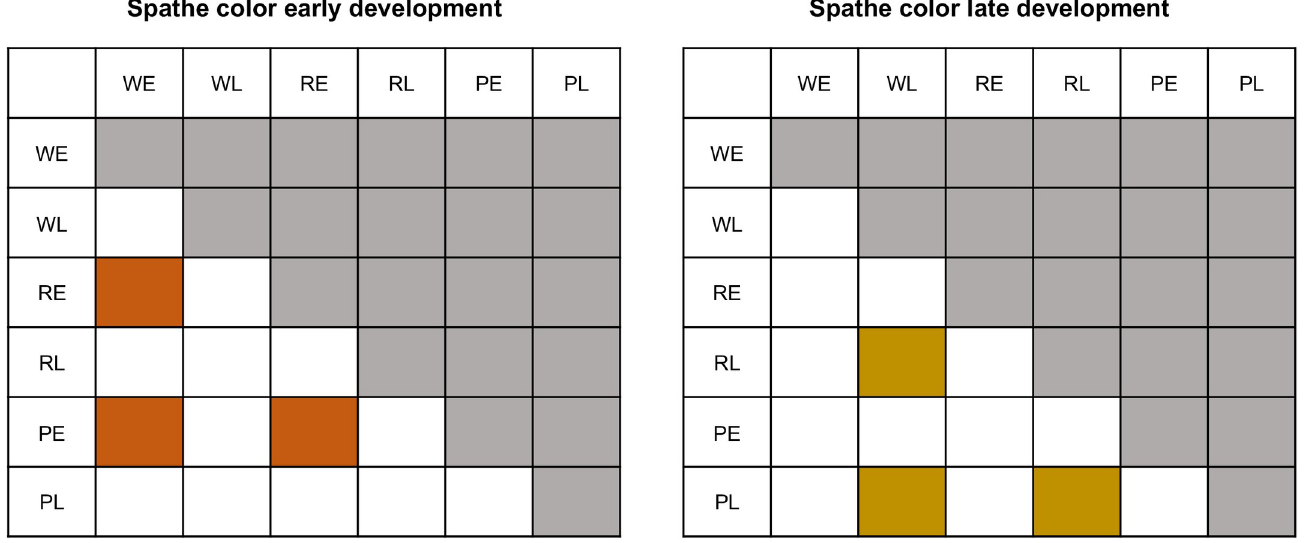
Fig 2. Matrices depicting specific contrasts designed to identify genes differentially expressed. Comparisons between spathes of different colors (W, R, P) in stage 2 (Early (E)); and between spathes of different colors in stage 6 (Late (L)).